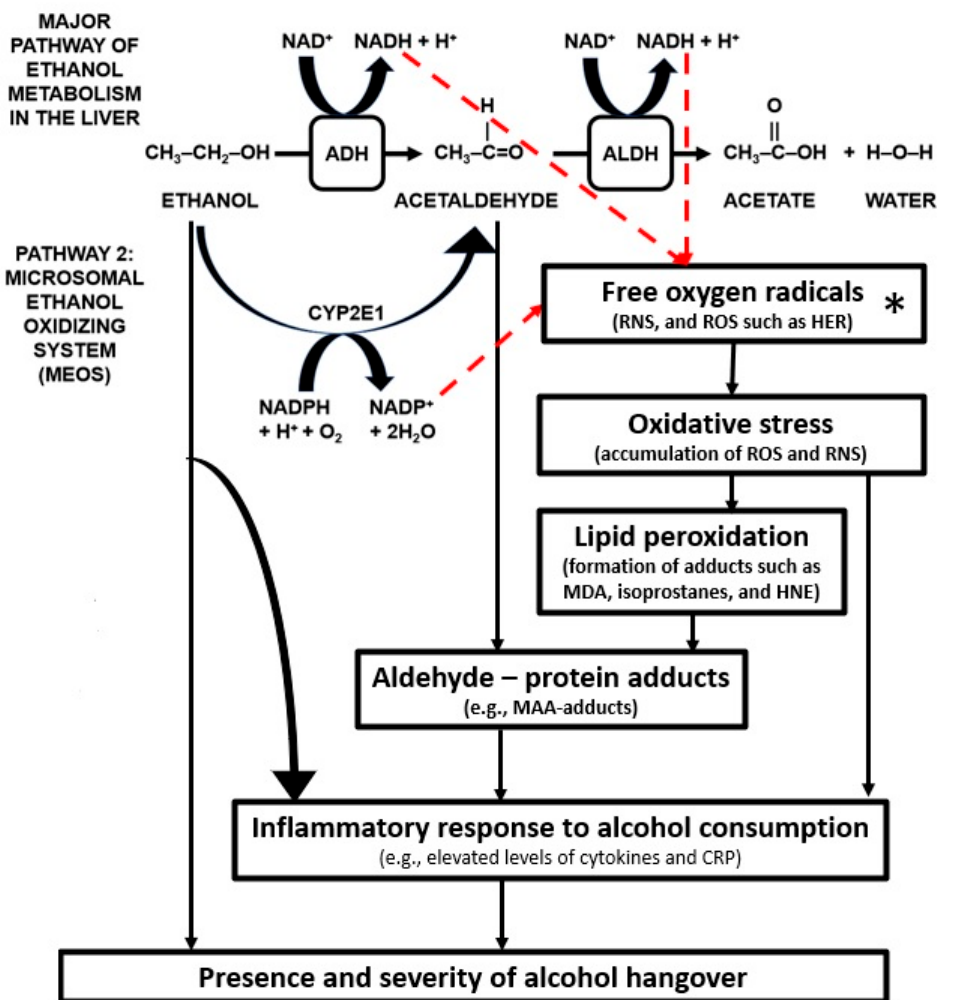
Figure 4. Oxidative stress and the inflammatory response to alcohol consumption. Arrows in red represent the relationship between alcohol metabolism and oxidative stress. Other arrows illustrate the pathways from oxidative stress to an inflammatory response and eliciting the alcohol hangover. Abbreviations: ADH = alcohol dehydrogenase, ALDH = aldehyde dehydrogenase, CRP = C-reactive protein, HER = hydroxyethyl radical, HNE = 4-hydroxy-2-nonenal, MAA = malondialdehyde – acetaldehyde, MDA = malondialdehyde (MDA), NAD + = nicotinamide adenine dinucleotide, NADH = nicotinamide adenine dinucleotide (NAD) + hydrogen (H), NADP + = nicotinamide adenine dinucleotide phosphate, NADPH = nicotinamide adenine dinucleotide phosphate + hydrogen (H), RNS = reactive nitrogen species, ROS = reactive oxygen species. Pathways contributing to ROS production are indicated by red dashed lines. * = free radicals are scavenged by antioxidants such as superoxide dismutase (SOD), catalase, and glutathione peroxidase, which may counteract lipid peroxidation and oxidative stress, and mitigate a subsequent inflammatory response.